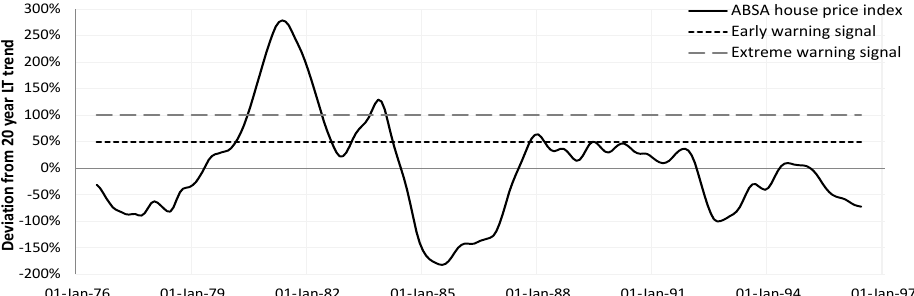
Deviation of the ABSA House Price Index from its 20-year long-term trend leading up to the 1997-1999 period of financial distress